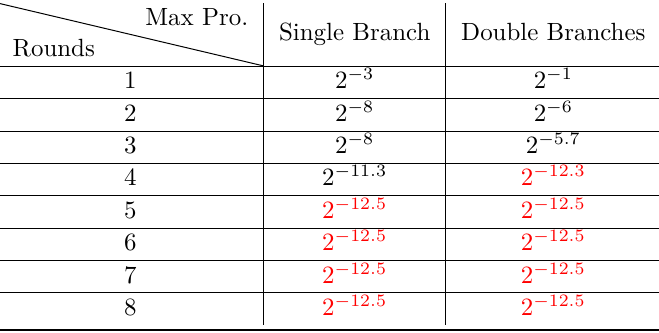
Table 11: The maximal differential probability of SPN-based toy ciphers. Rounds